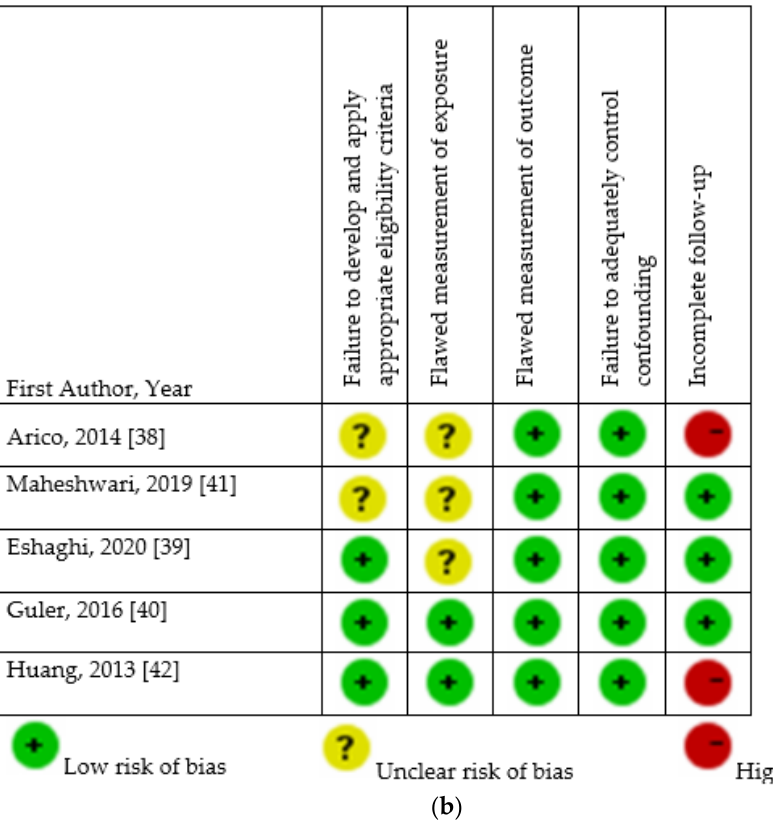
Figure 2. Risk of bias of included studies. ( a ). Risk of bias of included randomized controlled trials. ( b ). Risk of bias of included non-randomized studies [24–42]. Findings from the included studies are presented in Table 2.